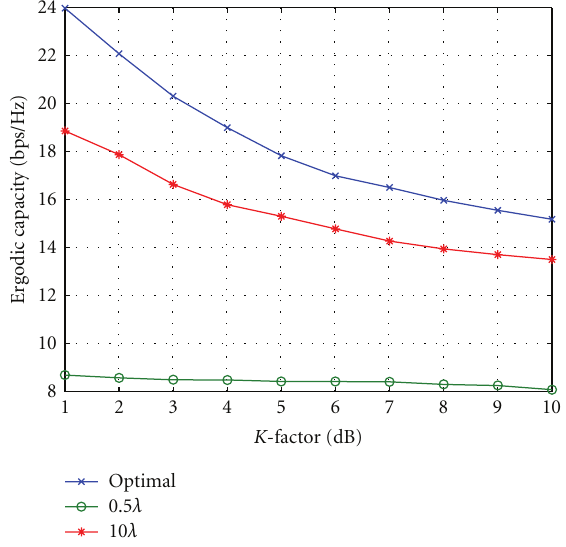
Figure 8: Ergodic capacity as a function of K -factor for di ff erent antenna spacings ( ρ = 10 dB, x =